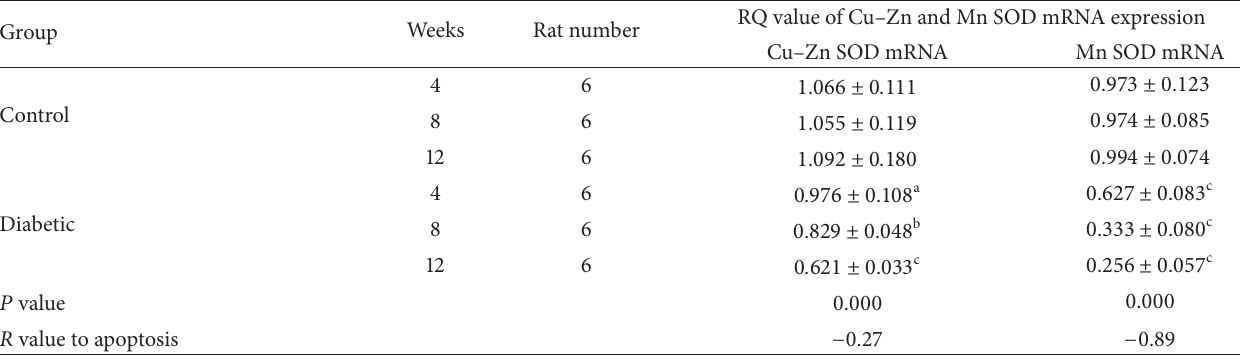
Table 3: RQ value of Cu–Zn and Mn SOD mRNA expression at 4, 8, and 12